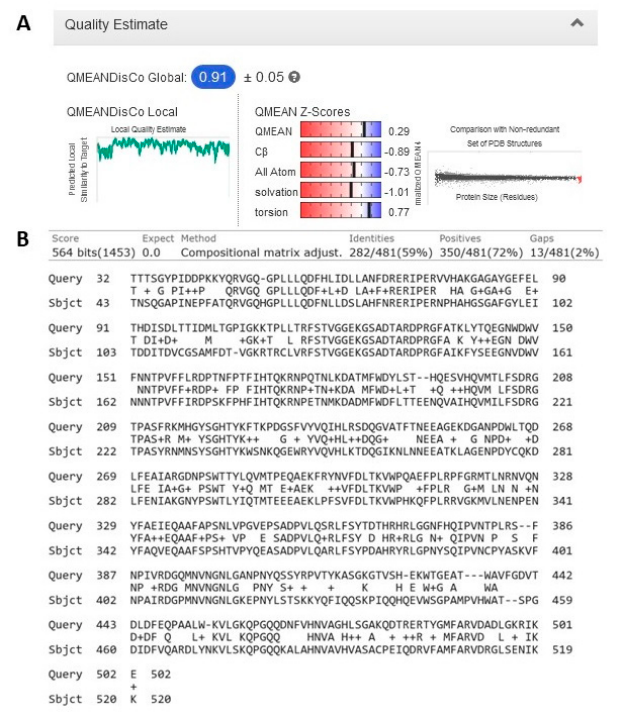
Figure 3. ( A ) Quality estimate of predicted structure of catalase from S. schenckii . ( B ) Amino acid alignment of from S. schenckii and the template Kluyveromyces lactis catalase.